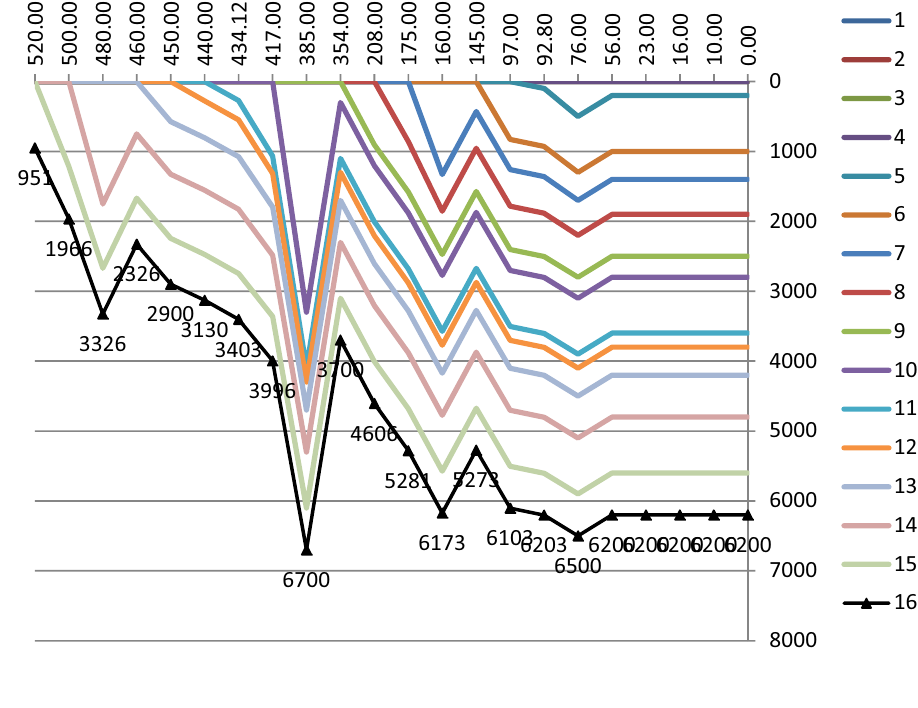
Fig. 6 Curve chart of burial his- tory for strata